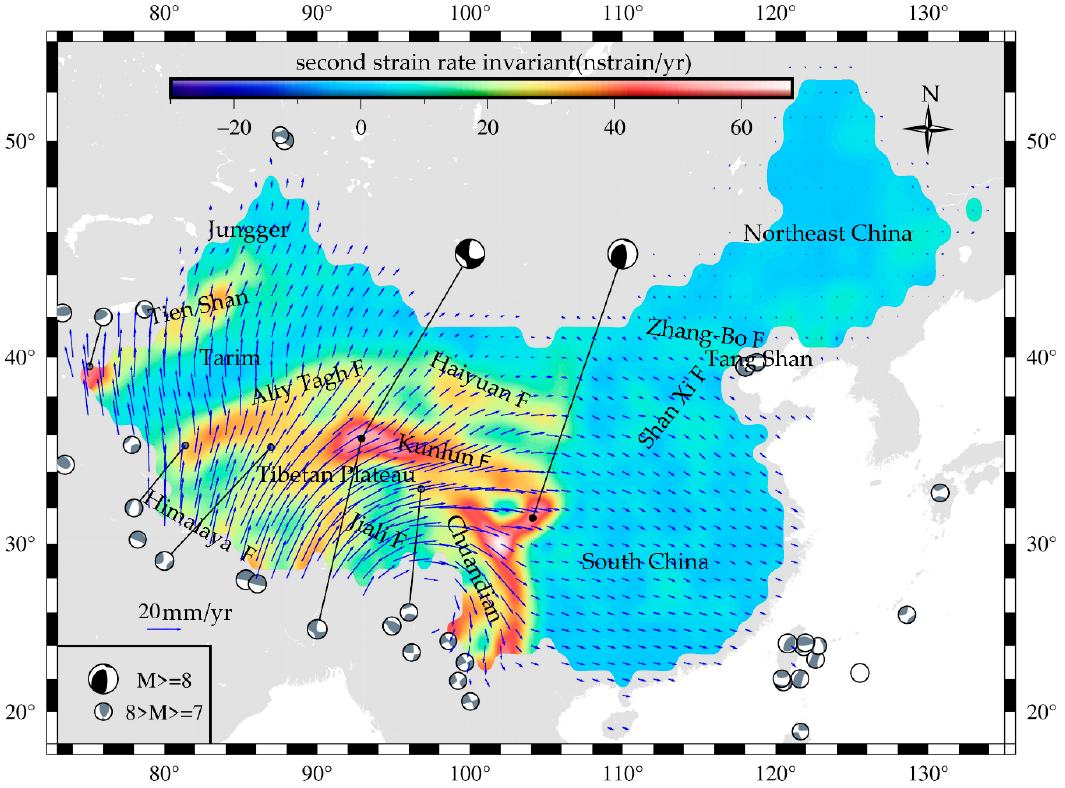
Figure 7. The distribution of strong earthquake and the second strain rate invariant is shown in background-color. Chuandian represents Sichuan-Yunnan.